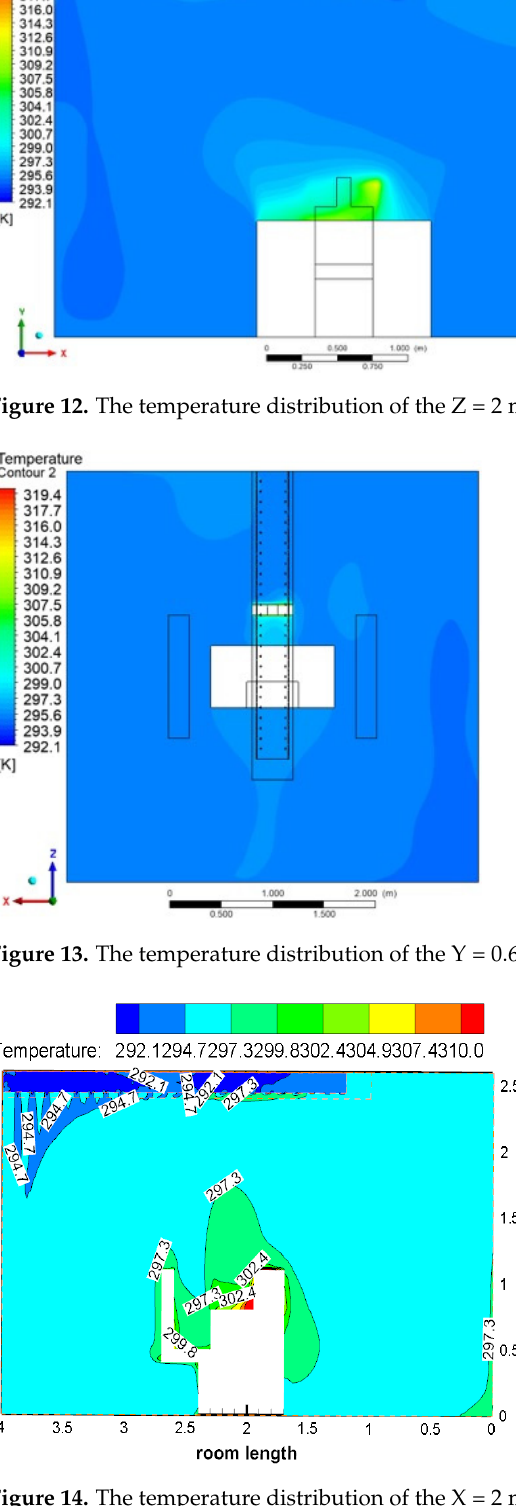
Figure 14. The temperature distribution of the X = 2 m section.